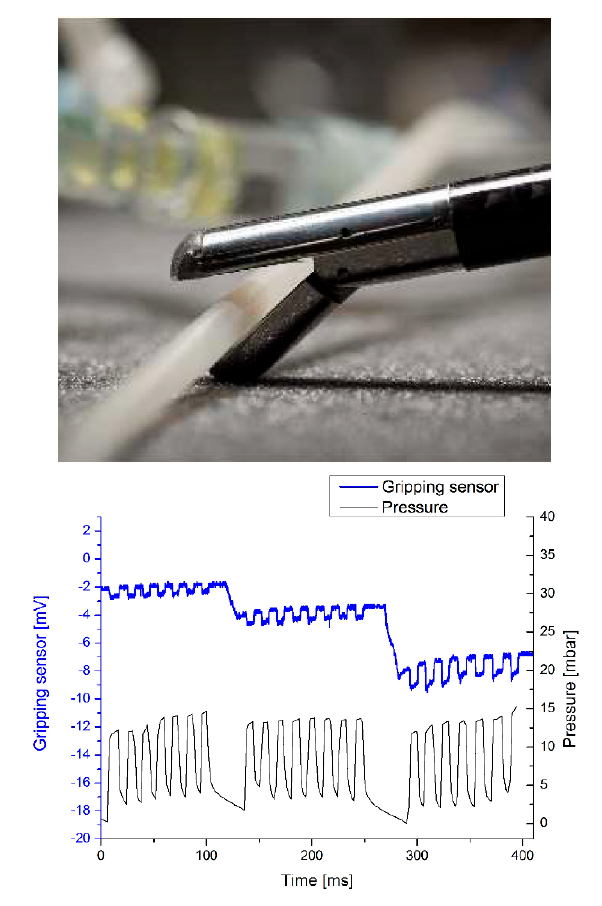
Figure 3. The signals of the grasping force sensors and the pressure sensor built in the fluidic system when applying pulse mode pressure. The three series are taken using different preset grasping